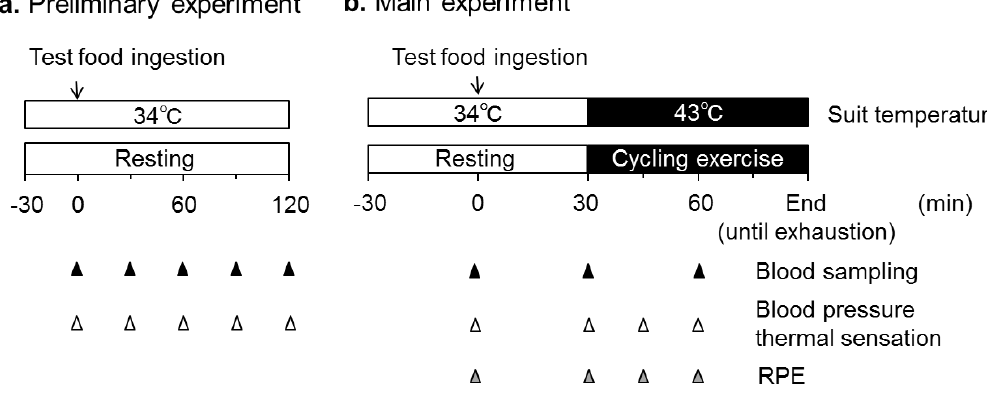
Figure 1. Schematic timeline of the experimental protocols for the preliminary and main experiments. RPE, rating of perceived exhaustion.